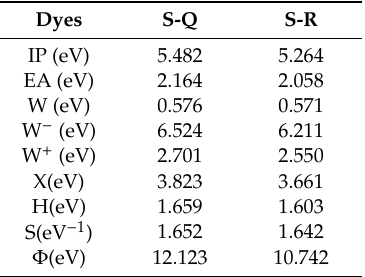
Table 2. Molecular descriptor parameters of S-Q and